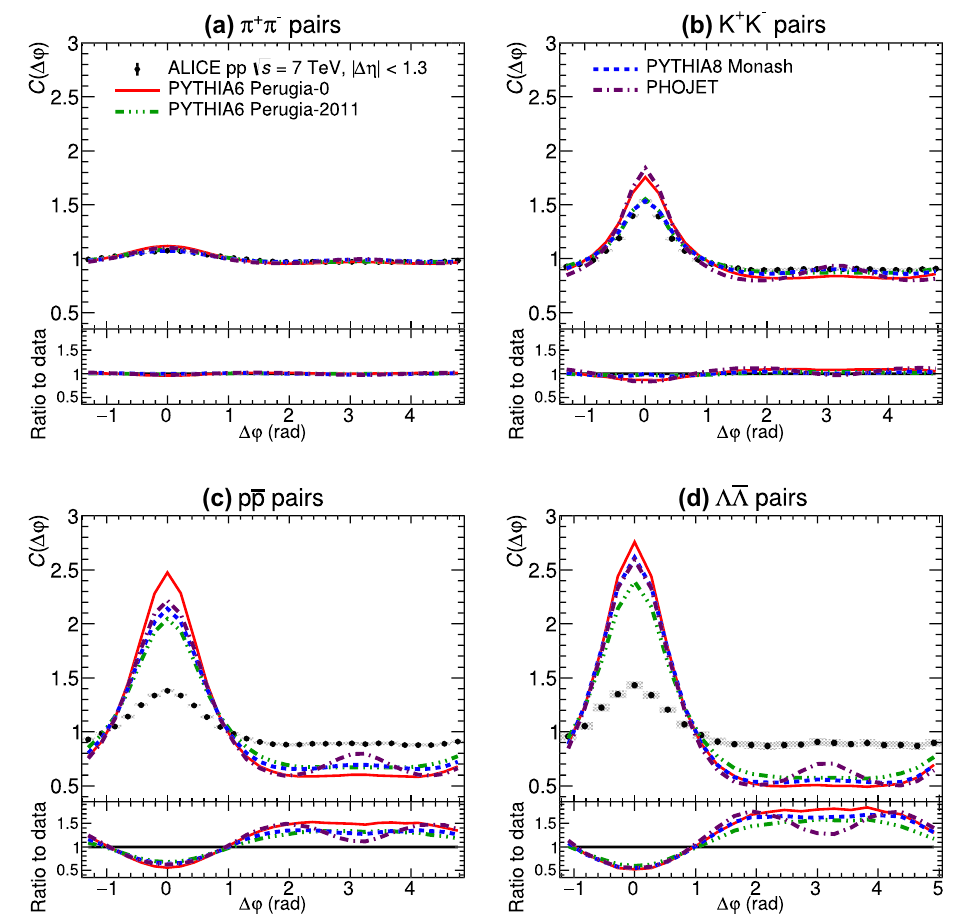
√ s = 7 TeV. Bottom panels show PYTHIA8 Monash, PHOJET) at ratios of MC models to ALICE data. Statistical ( bars ) and systematic ( boxes ) uncertainties are